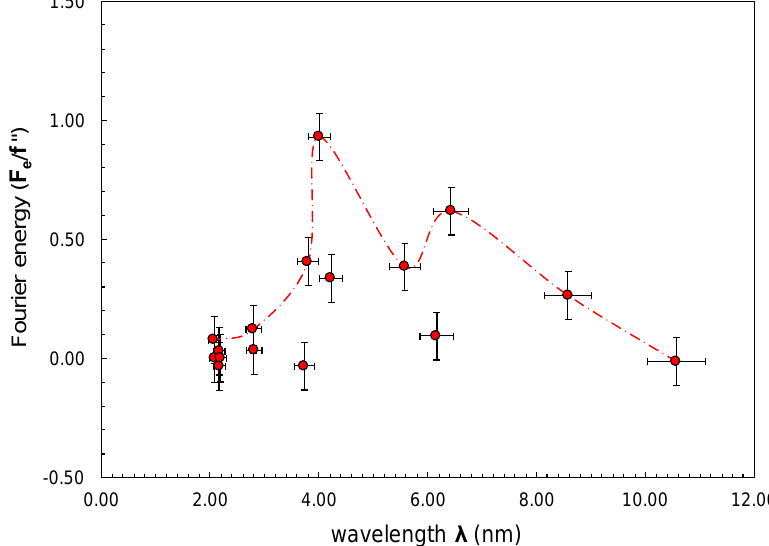
Figure 5. The variation of the Fourier energy term ( F e / f ″) with composition wavelength λ (nm) is computed from the interdiffusivity data for the Cu-Ni(Fe) nanolaminates at 23 °C. Table 2. Computed diffusivity and gradient energy coefficients for Cu-Ni(Fe) at 23 °C. Curve Fit